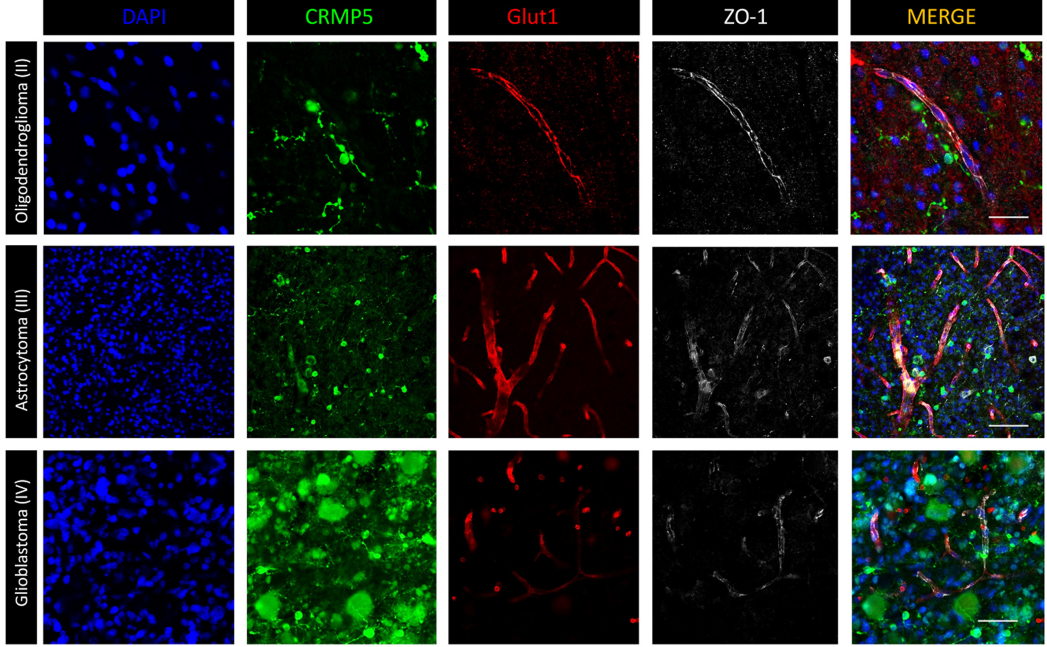
Figure 4. Immunofluorescence with anti-CRMP5 for staining of the tumor cells and with anti-Glut1 and anti-ZO1 for staining of BBB. In low grade gliomas (grade II oligodendroglioma, upper panels; Case #3 on Table 1), a few morphologically differentiated tumor cells do not disrupt the BBB that appears well preserved with maintained Glut1 and ZO1 staining. Scale bar, 50 μ m. High grade gli- oma (grade III astrocytoma, middle panels; Case #5 on Table 1) show an increased density of blood vessels with discontinuous Glut1 and lost of ZO1 dotted staining. Scale bar, 100 μ m. In GBM (grade IV astrocytoma, lower panels; Case #26 on Table 1), the CRMP5 expressing tumor cells are morpho- logically heterogeneous. The blood vessels show highly disrupted BBB with losing of Glut1 and